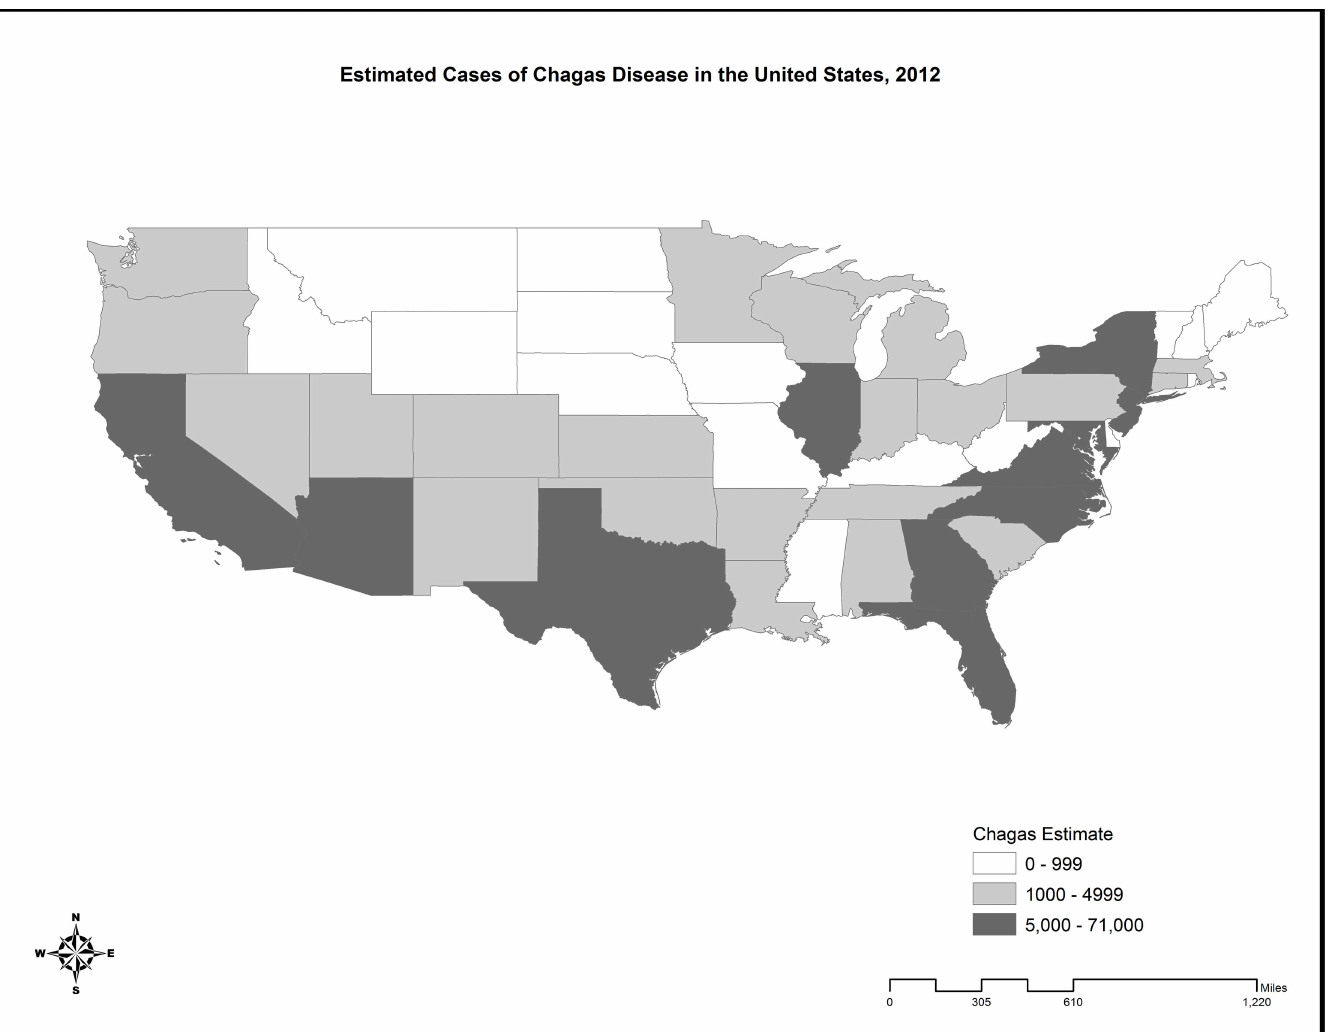
Fig 1. Map of estimated cases of Chagas disease in the United States,